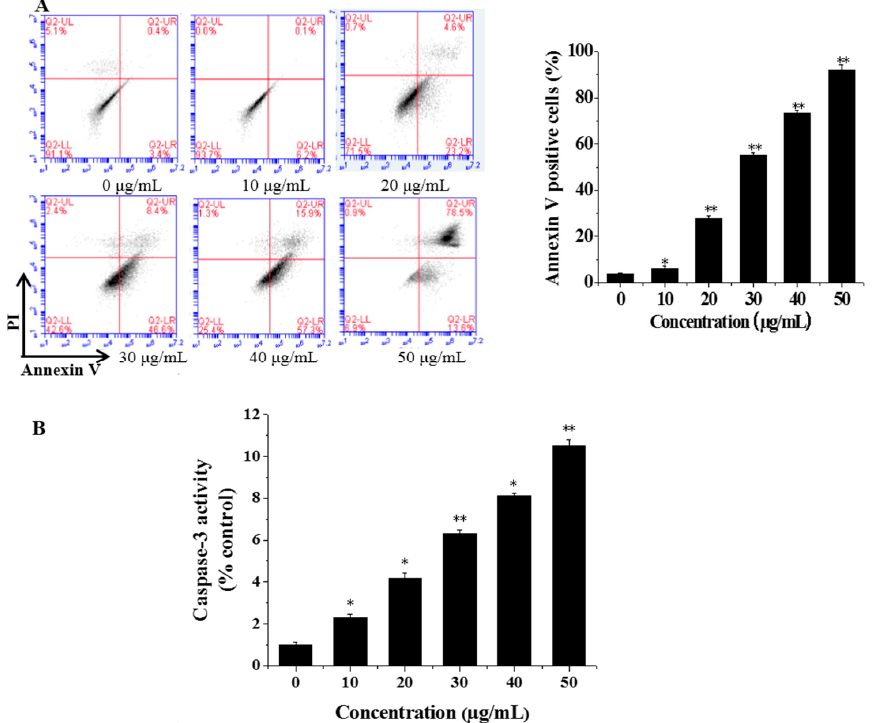
Figure 5. The analysis of Caco-2 cells apoptosis induced by CGC. ( A ) Flow cytometric analysis of MGC-803 cell apoptosis. Caco-2 cells were treated with CGC at 0 (control), 10, 20, 30, 40 and 50 μ g/mL; ( B ) Caspase-3 activity in Caco-2 cells treated with 0, 10, 20, 30, 40 and 50 μ g/mL of CGC, respectively. Caspase-3 activity was measured by caspase-3 colorimetric assay. All results are the means ± SD ( n = 3). * p < 0.05 and ** p < 0.01, compared to control group.